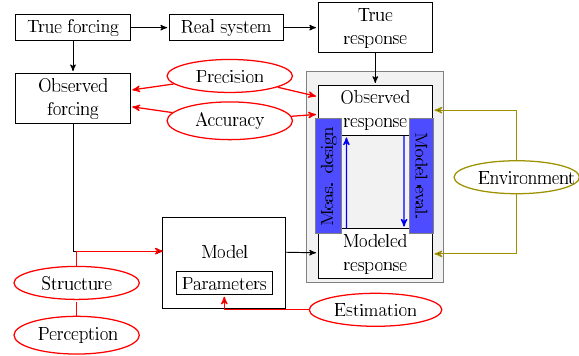
Fig. 1. Model uncertainties and errors has diverse sources (red) such as unknown parameters, errors in input data, numerical errors due to discretization, etc. Uncertainty and sensitivity studies inves- tigate the effect of these possible sources of errors on model outputs (adapted from Gupta et al., 2005). Observed and modeled responses as well as model sensitivities are subject to strong environmental